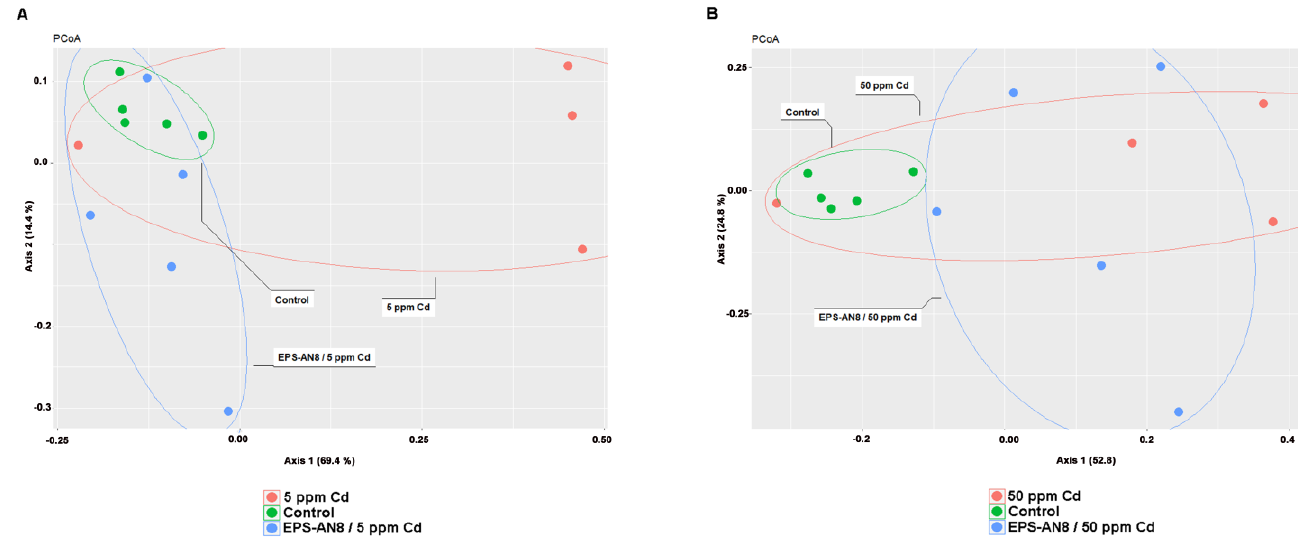
Figure 5. PCoA representation of microbial diversity comparison between control group and groups treated with lower dose of Cd ( A ); PCoA representation of comparison of microbial content between control group and groups treated with higher dose of Cd ( B ). Table 1. Beta diversity of gut microbiota expressed through Anosim.